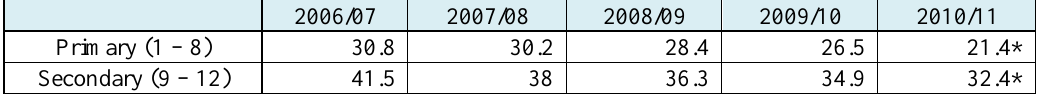
Table 4-11: Percentage of Schools with Shift System (2006/07 - 2010/11)